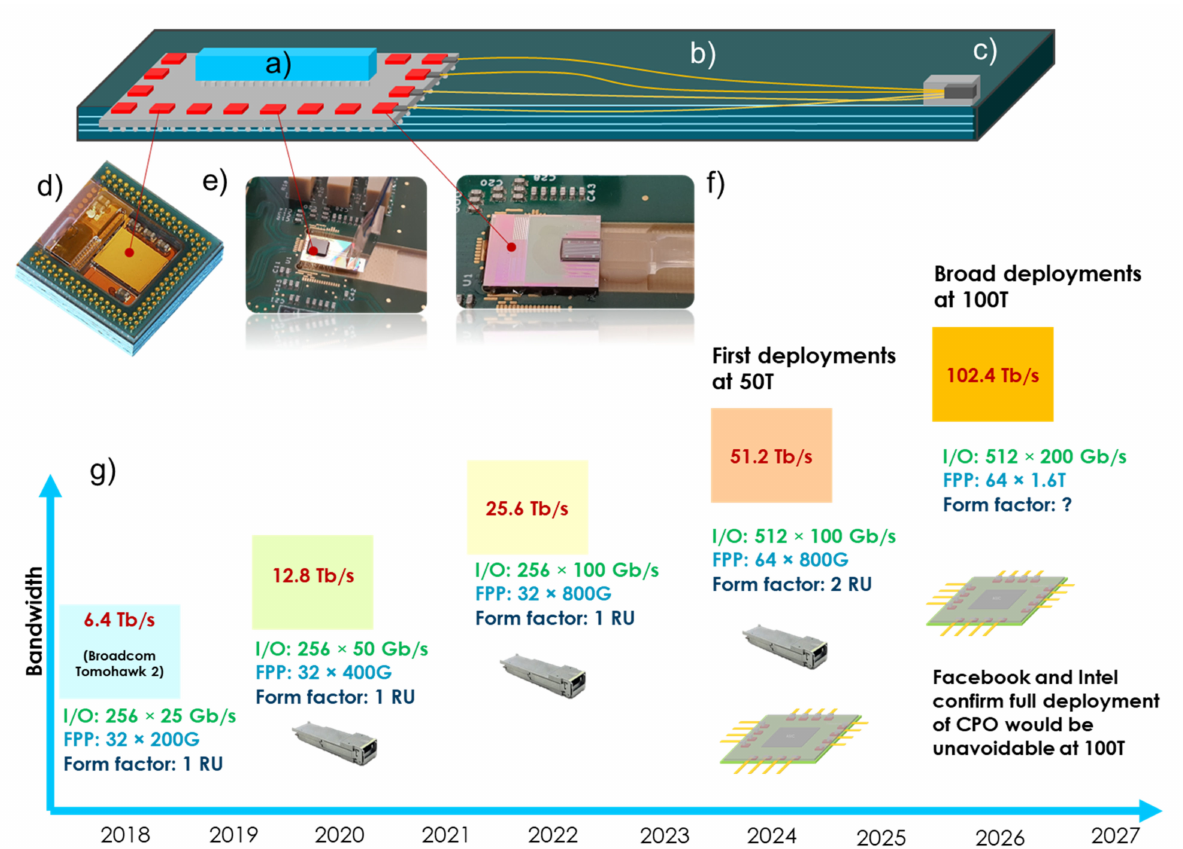
Figure 16. Copackaged optical assembly: ( a ) schematic view of copackaged optical module compris- ing an ASIC (blue) and transceiver chiplets (red) on common carrier (grey) mounted on PCB (green) of a host card [31], ( b ) optical fiber connections from the copackaged optical module to ( c ) passive optical connector at front face-plate and/or backplane/midplane interface, ( d ) example of transceiver chiplet (courtesy of AIO Core Ltd.) [31,32], ( e ) 1st generation silicon photonics transceiver from H2020 COSMICC, ( f ) 2nd generation of silicon photonics transceiver from H2020 COSMICC project [33], ( g ) projected timeline for data center switch ASICs with increasing aggregate